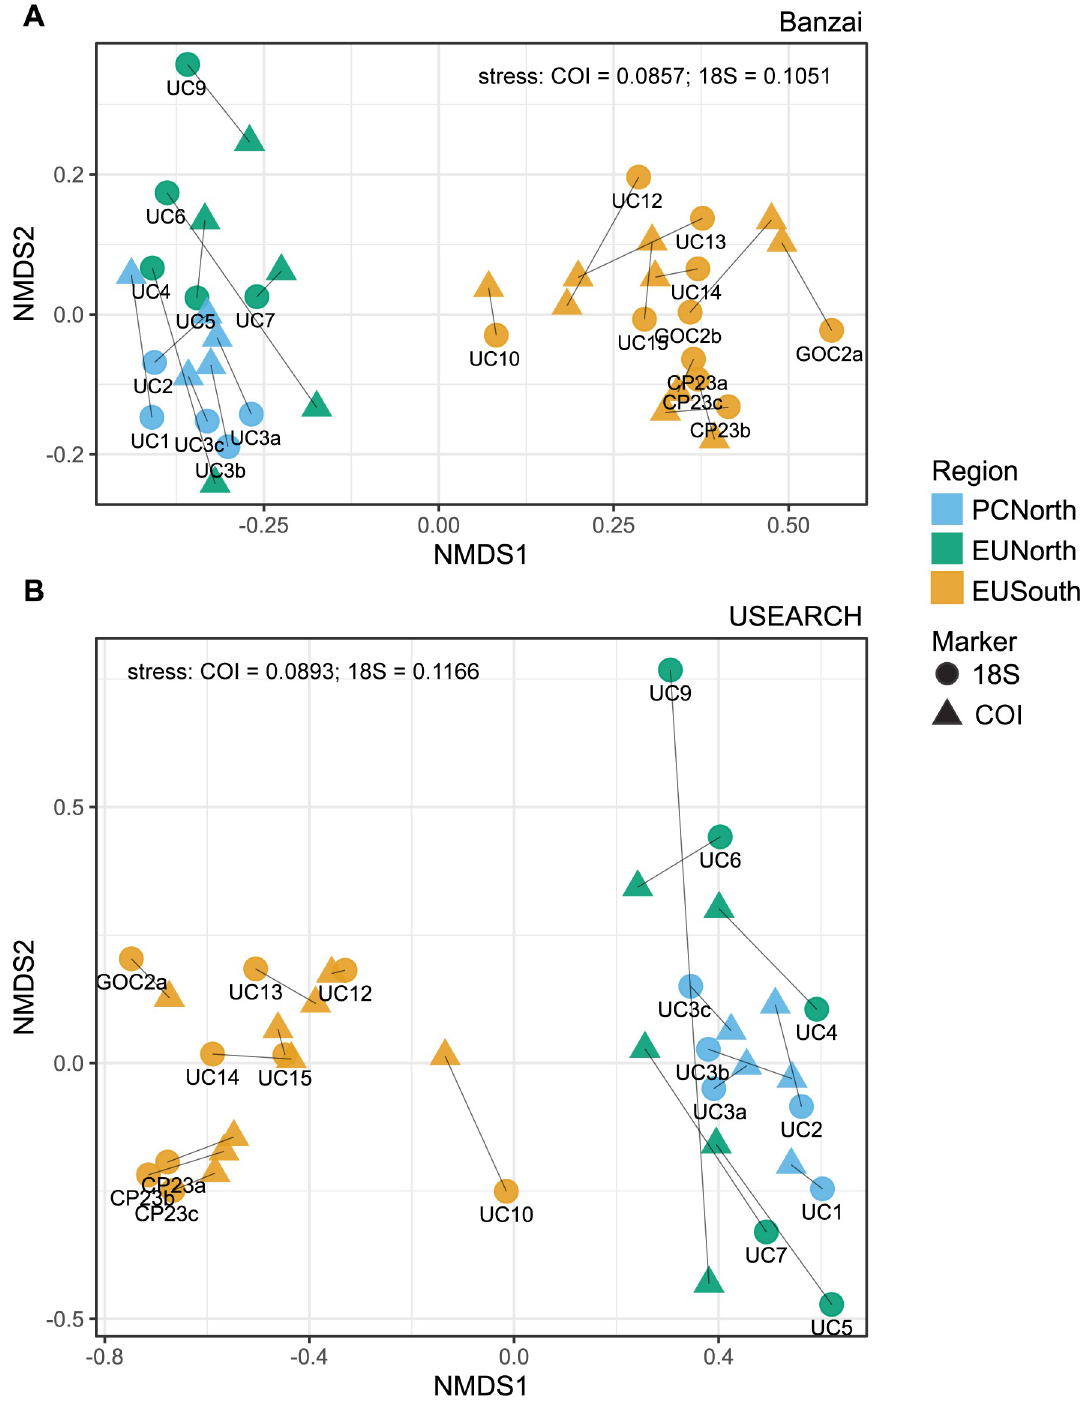
Fig 4. Procrustes analysis of NMDS plots. Comparison of clustering within NMDS plots by procrustes analysis with Bray-Curtis distance for (A) Banzai 18S and COI and (B) USEARCH 18S and COI.